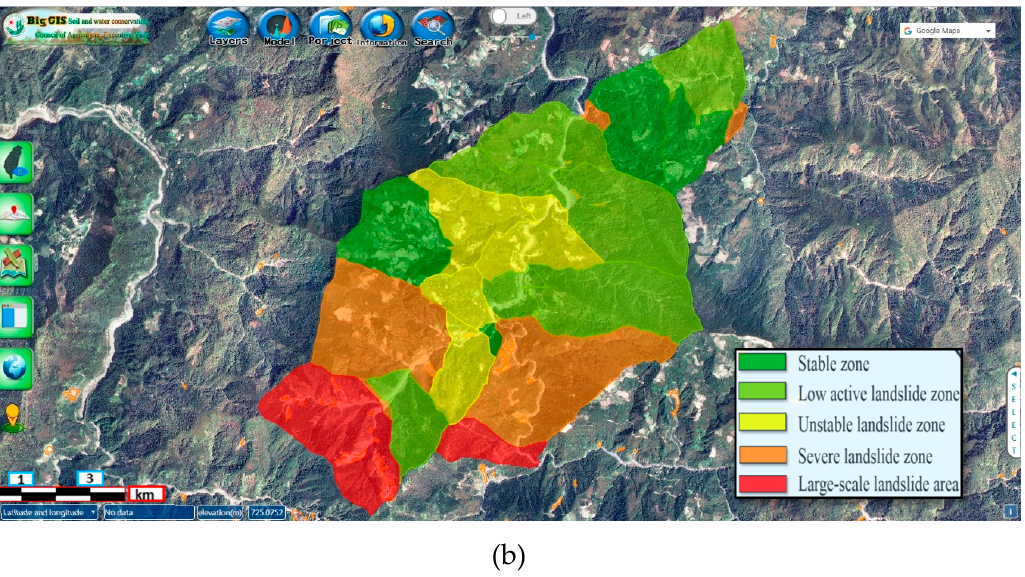
Figure 13. ( a ) locations and regions of 28 watersheds assessed by the SWCB (blue polygons), where the Qingquan watershed is annotated as a star; ( b ) quantitative assessment of the stability of the Qingquan watershed based on the instability index derived from a long-term landslide inventory. SWCB Big Geospatial Information System [40].